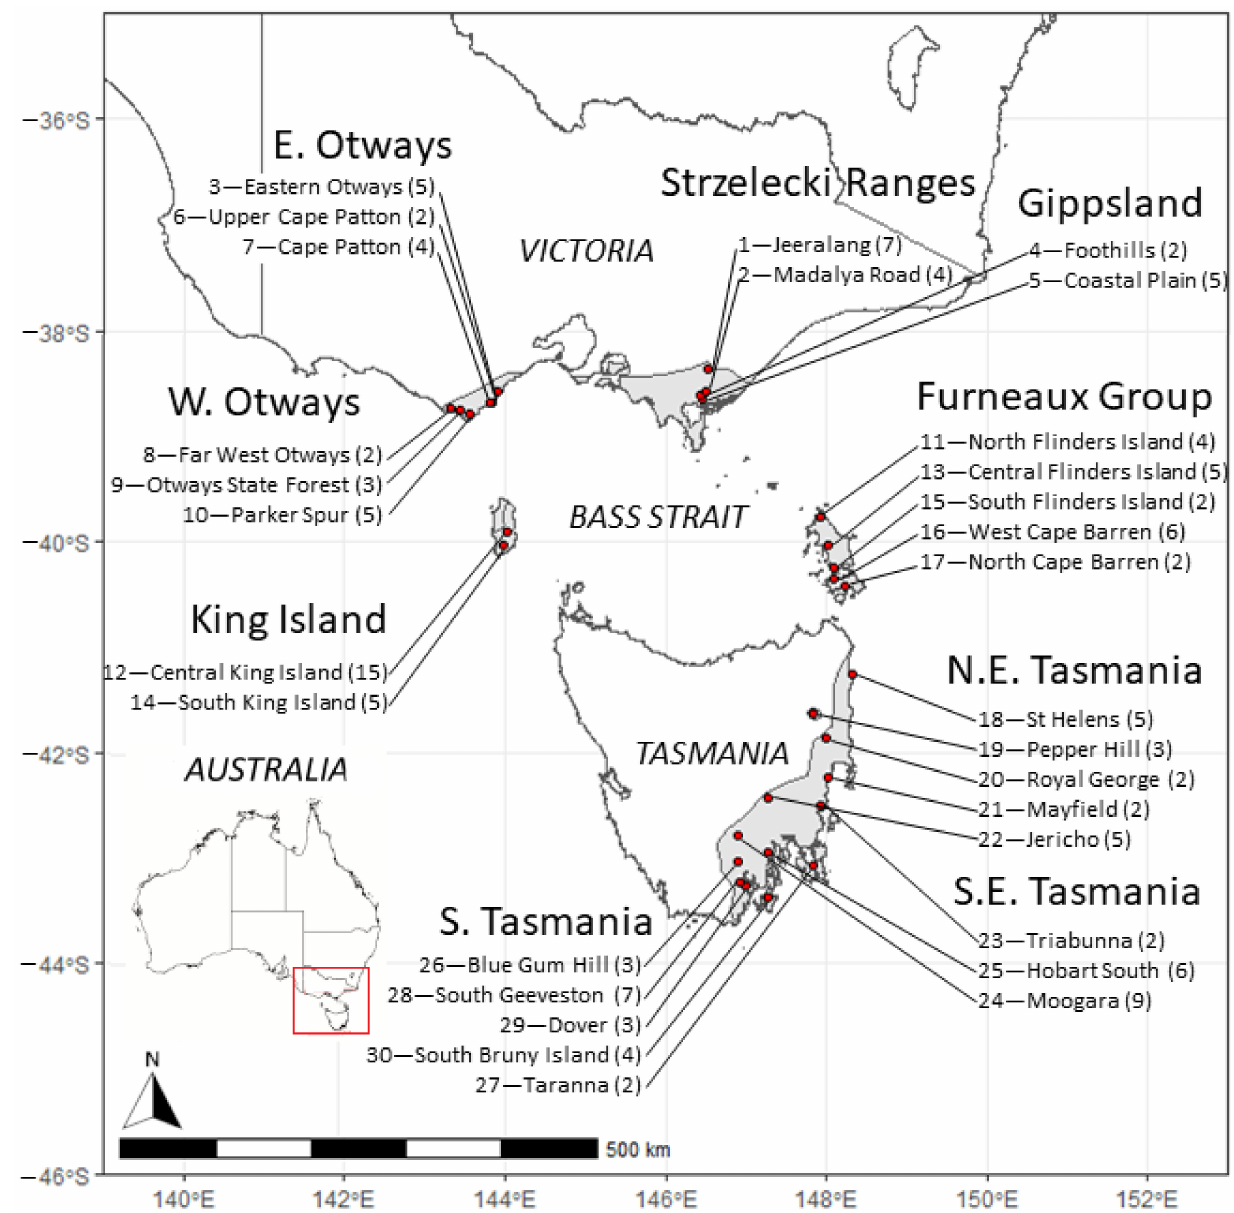
Figure 1. Geographical distribution of Eucalyptus globulus mother trees of the open-pollinated families sampled from each race in the genetic trial (also see Table S1). The inset plot indicates the region of Australia examined in this study. The grey area indicates the natural range of E. globulus in south-eastern Australia. The small disjunct occurrences on the west coast of Tasmania are not shown, as they were not included in the present study. The race (bold) and locality (below) names follow Dutkowski and Potts [49], with the first number indicating a locality identifier, and the number in parentheses indicating the number of open-pollinated progeny/mother trees sourced from each locality used in this study. The mapped area is shown on the inserted map of Australia showing state